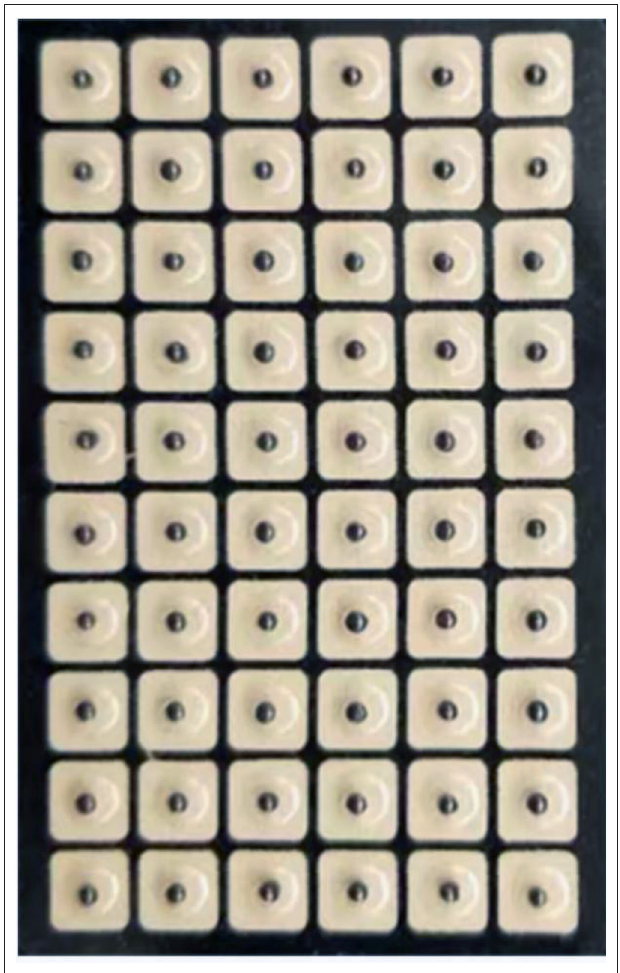
FIGURE 4 | The adhesive-backed ear patch “seeds” used for